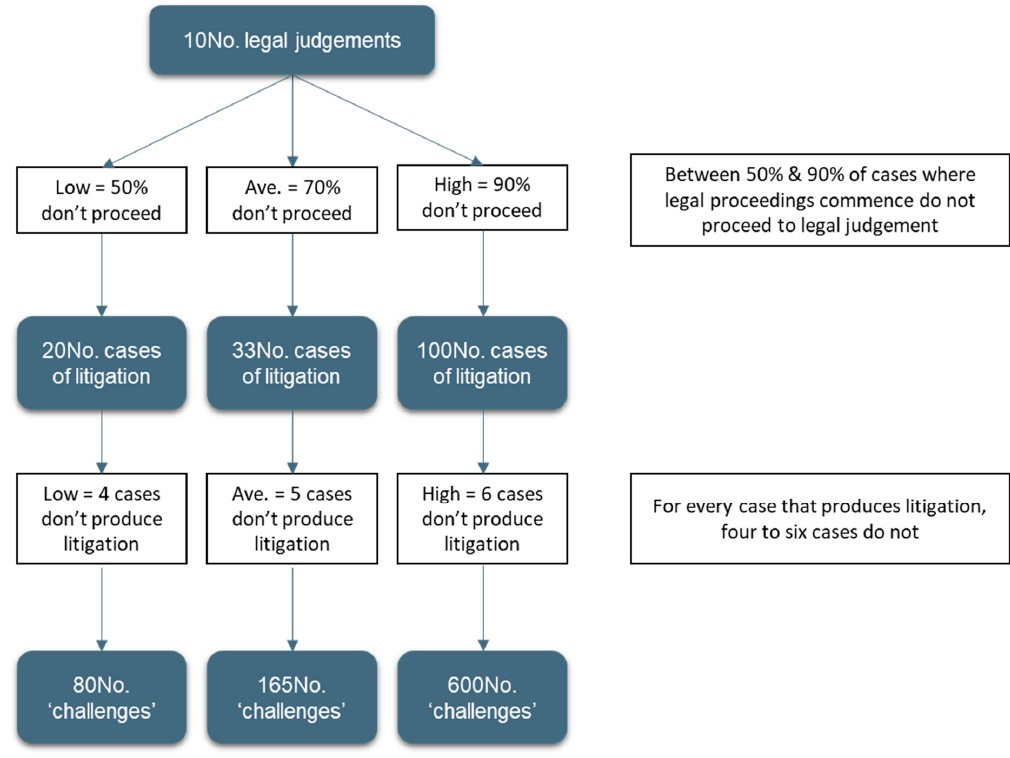
Figure 3. Ratio of legal judgements to legal challenges (as per Arrowsmith and Craven, 2016) [21].